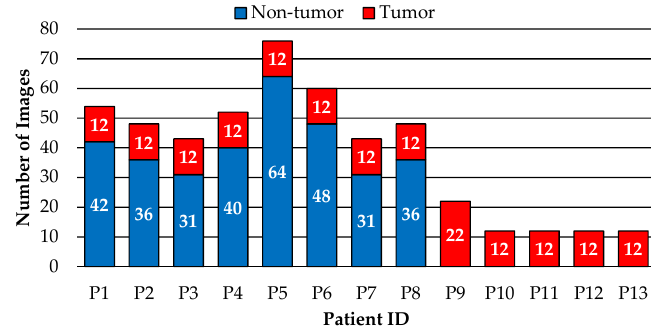
Figure 2. Number of non-tumor and tumor HS images per patient.